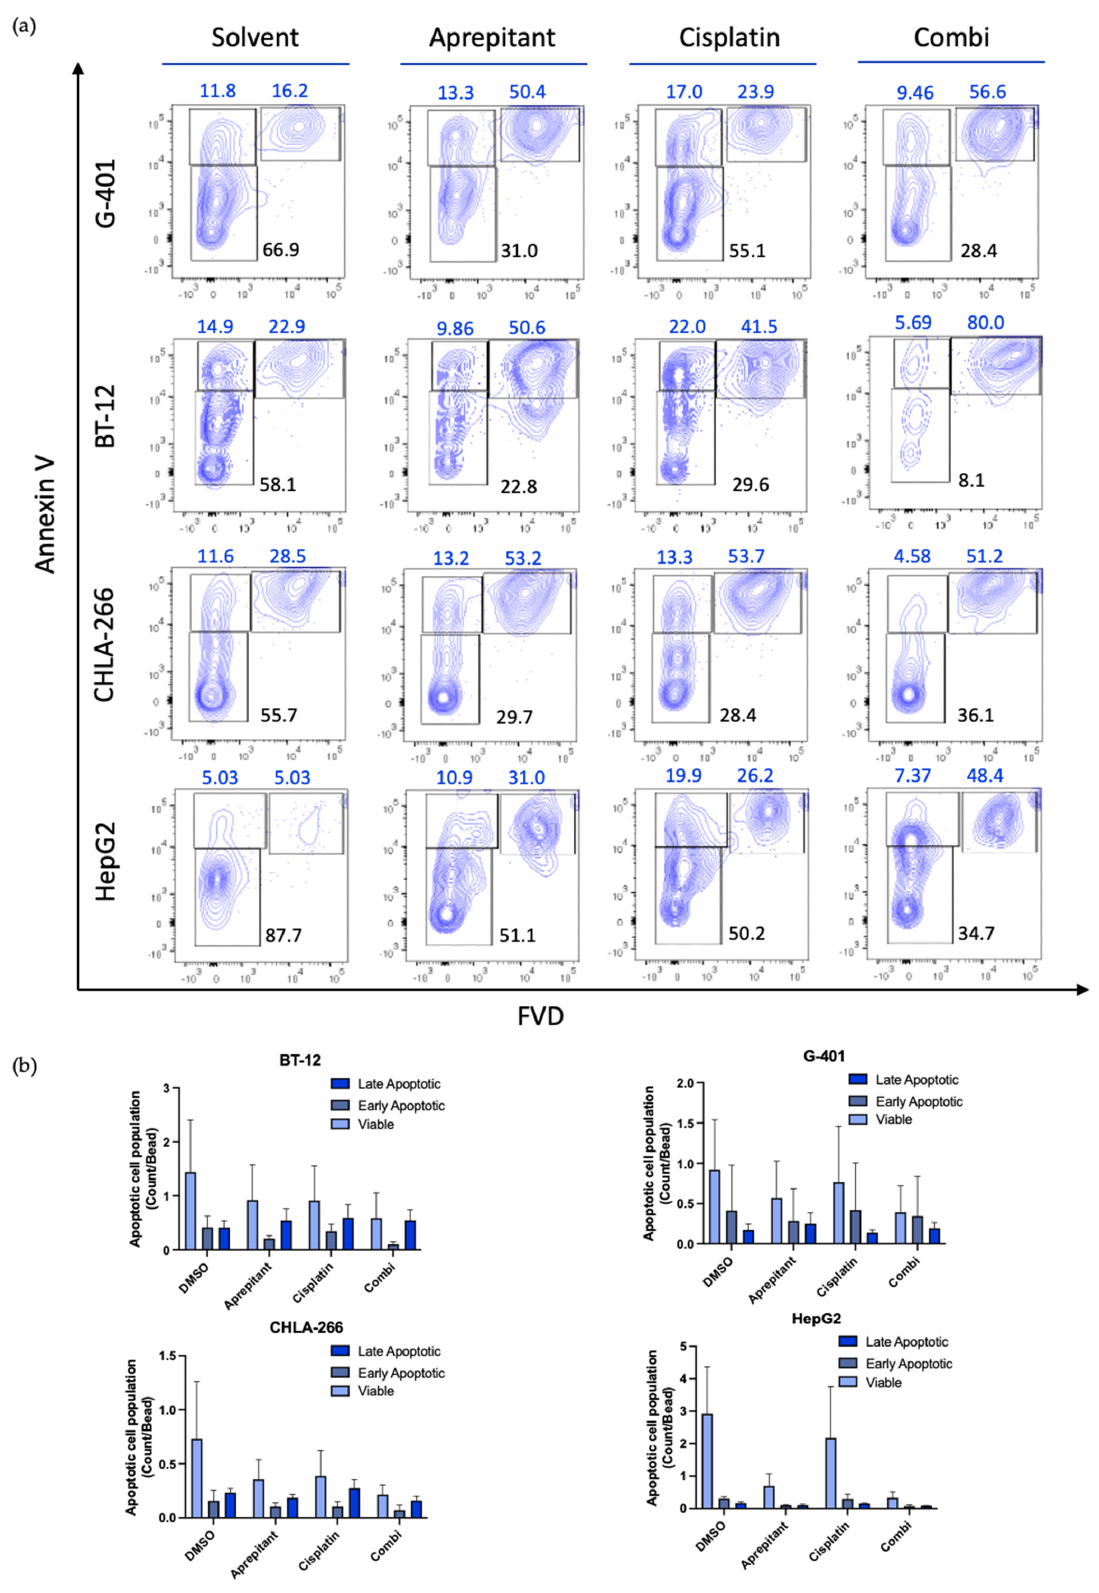
Figure 3. ( a ) Determination of apoptotic cell populations of G-401, BT-12, CHLA-266, and HepG2 was performed by staining with annexin V and fixable viability dye (FVD) and assessed